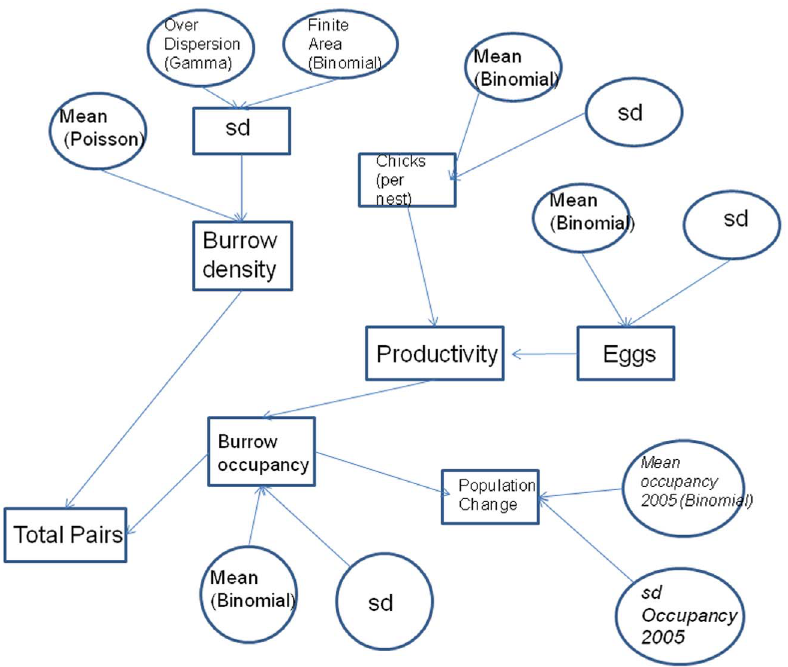
Figure 1. Directed Acyclic Graph. Directed Acyclic Graph of model for estimating flesh-footed shearwater population on Lord Howe Island. Rectangles represent derived variables, while ovals represent parameters that are estimated from data with uncertainty. Variables in italics were taken from the literature (see text). Other variables with parameters took vague priors.